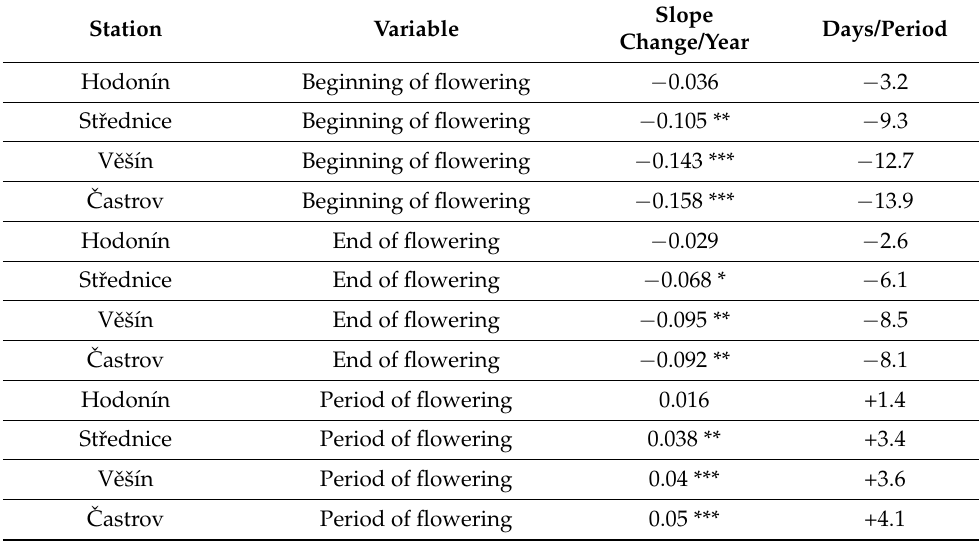
Table 5. Results of the M-K test of the beginning of flowering, end of flowering and period of the cherry tree flowering in the period of